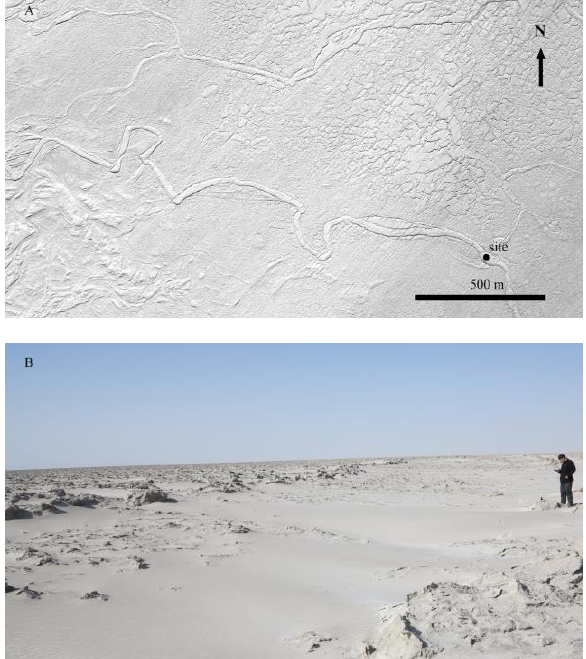
Figure 10 Similar landforms in Xinjiang, China. (A) The GF-2 image (ID: 1878208) shows the polygons and traces which are very similar to those on Mars. (B) The picture taken from the site marked in (A) with the camera pointing to the